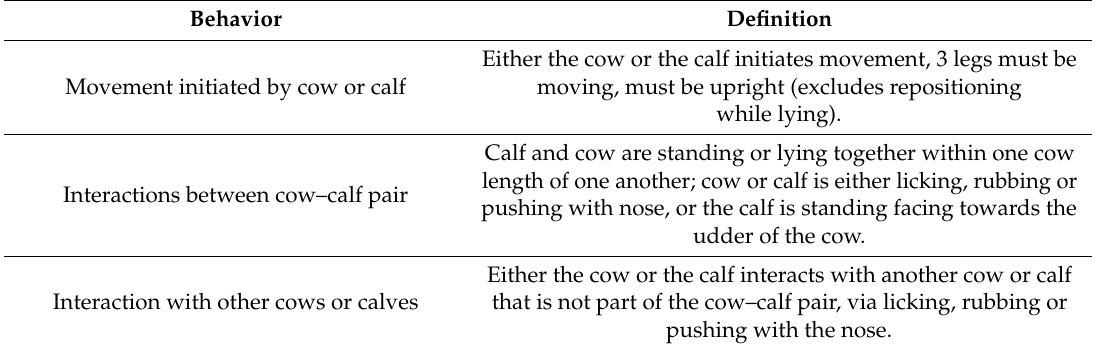
Table 1. Ethogram for coding interactions between cow–calf pairs and other cows and calves. Ten pairs which moved into hides where matched with 10 pairs that did not have hide access, but that calved within a similar timeframe. Behaviors were coded 30 min before moving into the hide, and 30 min after moving into the hide. Before and after periods for cow–calf pairs without access to a hide were based on their matched pairs’ hide entrance time relative to